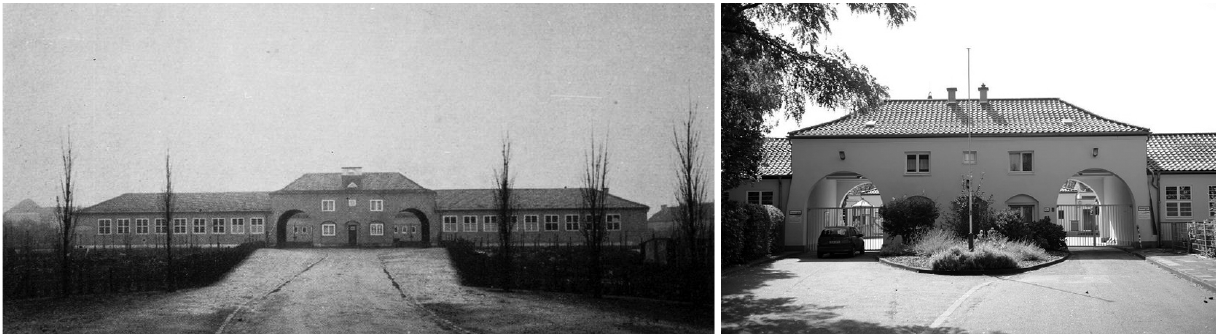
Figure 8. From left to right: W. Riphahn and K. M. Grod, Mauenheim school (Unknown, 1925, p. 128);